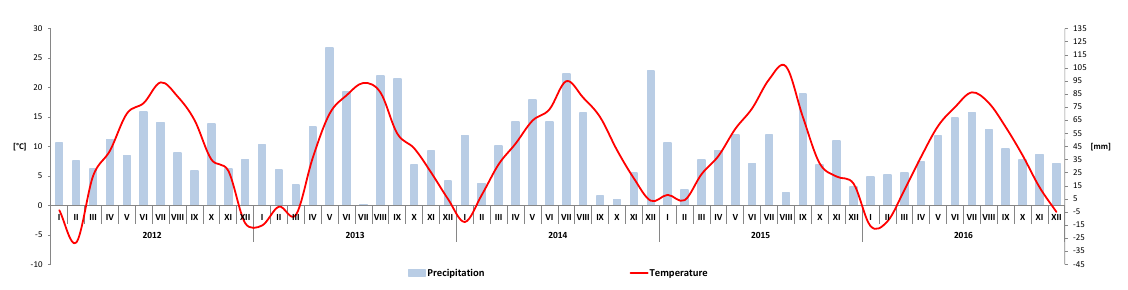
Figure 1. Weather conditions in the ‘Gold Chief’ apple orchard during 2012–2016. The experiment was set up using a randomized block design. The following methods of soil management in 1 m wide rows of trees were compared: (1) Herbicide strip (HS), was used as a control, for which 1 m soil width was sprayed with herbicide (glyphosate in the Roundup 360 SL formulation at a dose of 4 Lha − 1 ) at the beginning of June and after litter (MM), for which 1 m width of soil was mulched in rows of trees with a 10 cm